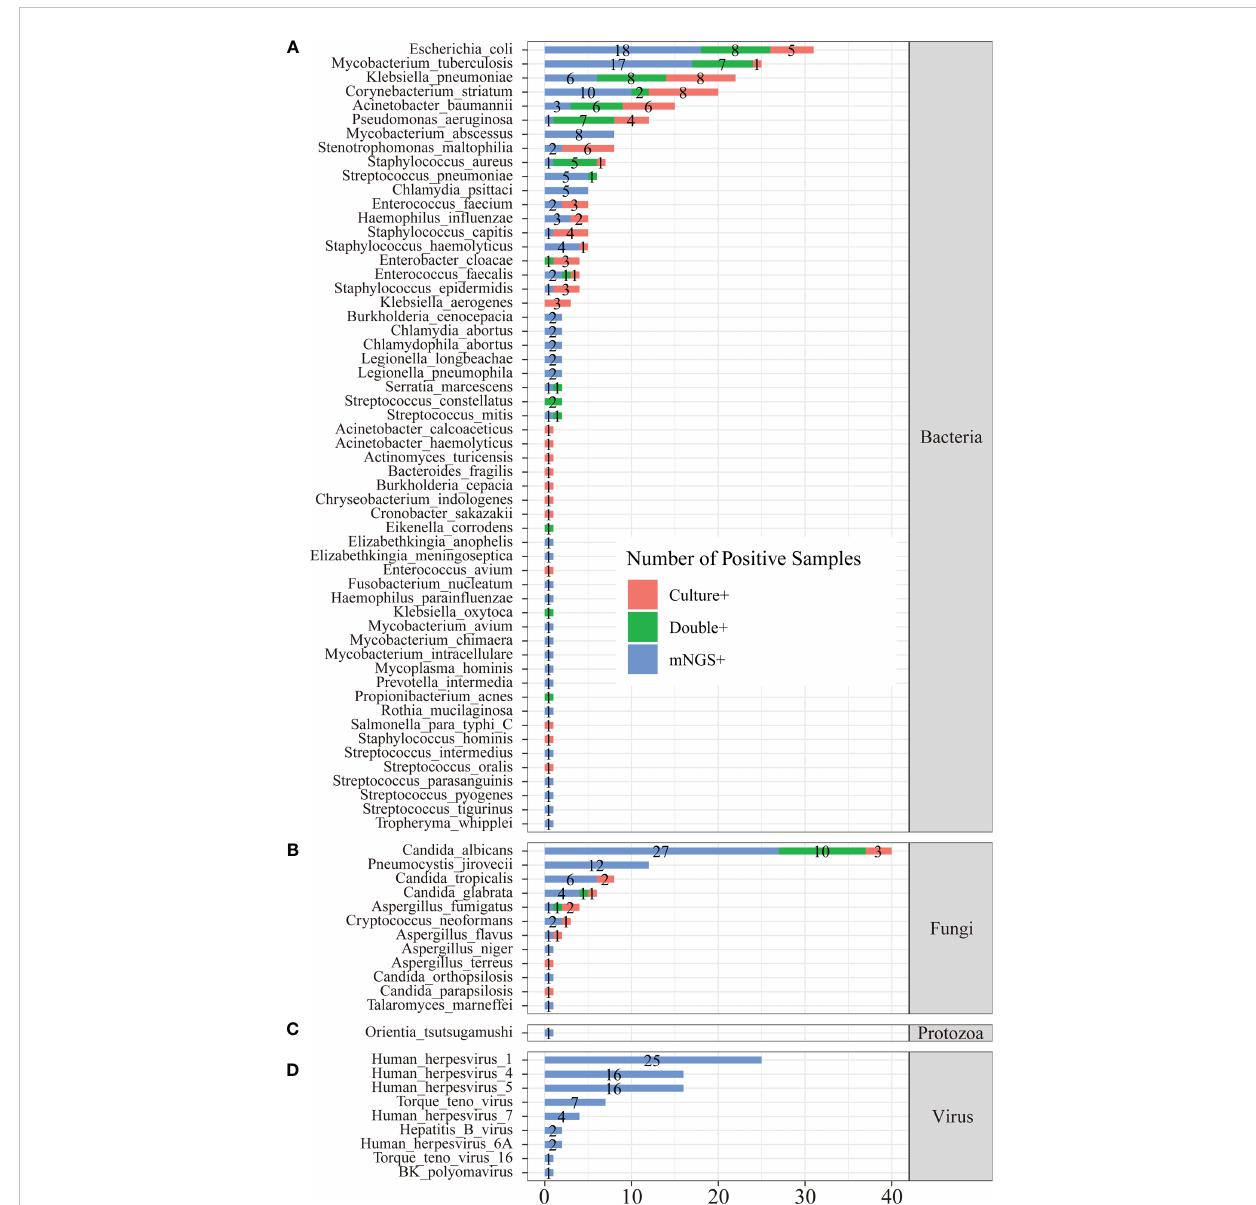
FIGURE 3 The comparison and overlap of infected pathogens between mNGS and laboratory culture in all 205 patients with CAP. (A) Bacteria levels; (B) fungi level; (C) protozoa level; and (D) virus